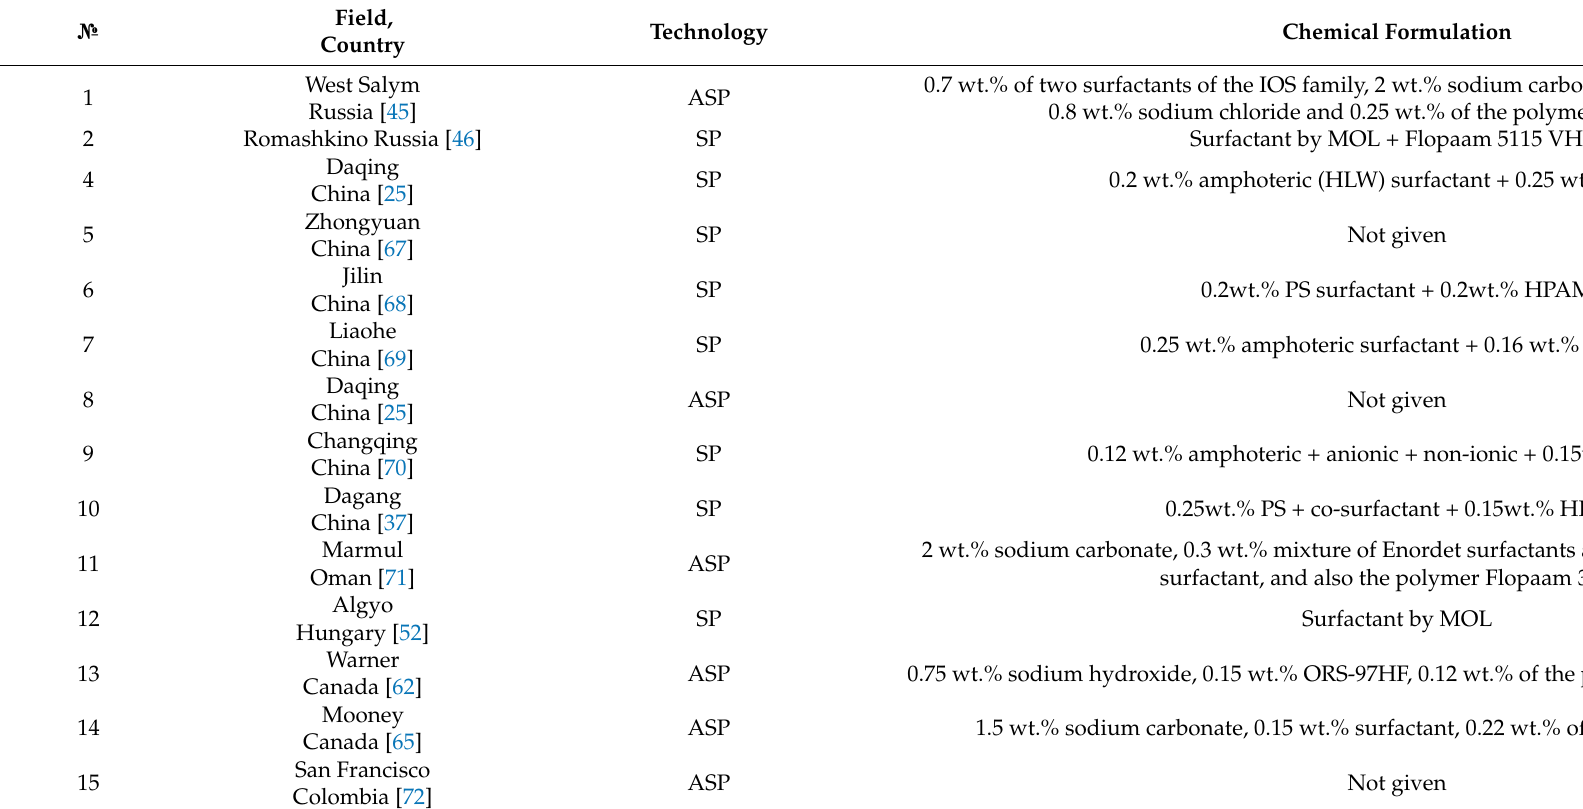
Table 3. Chemical formulation of SP and ASP